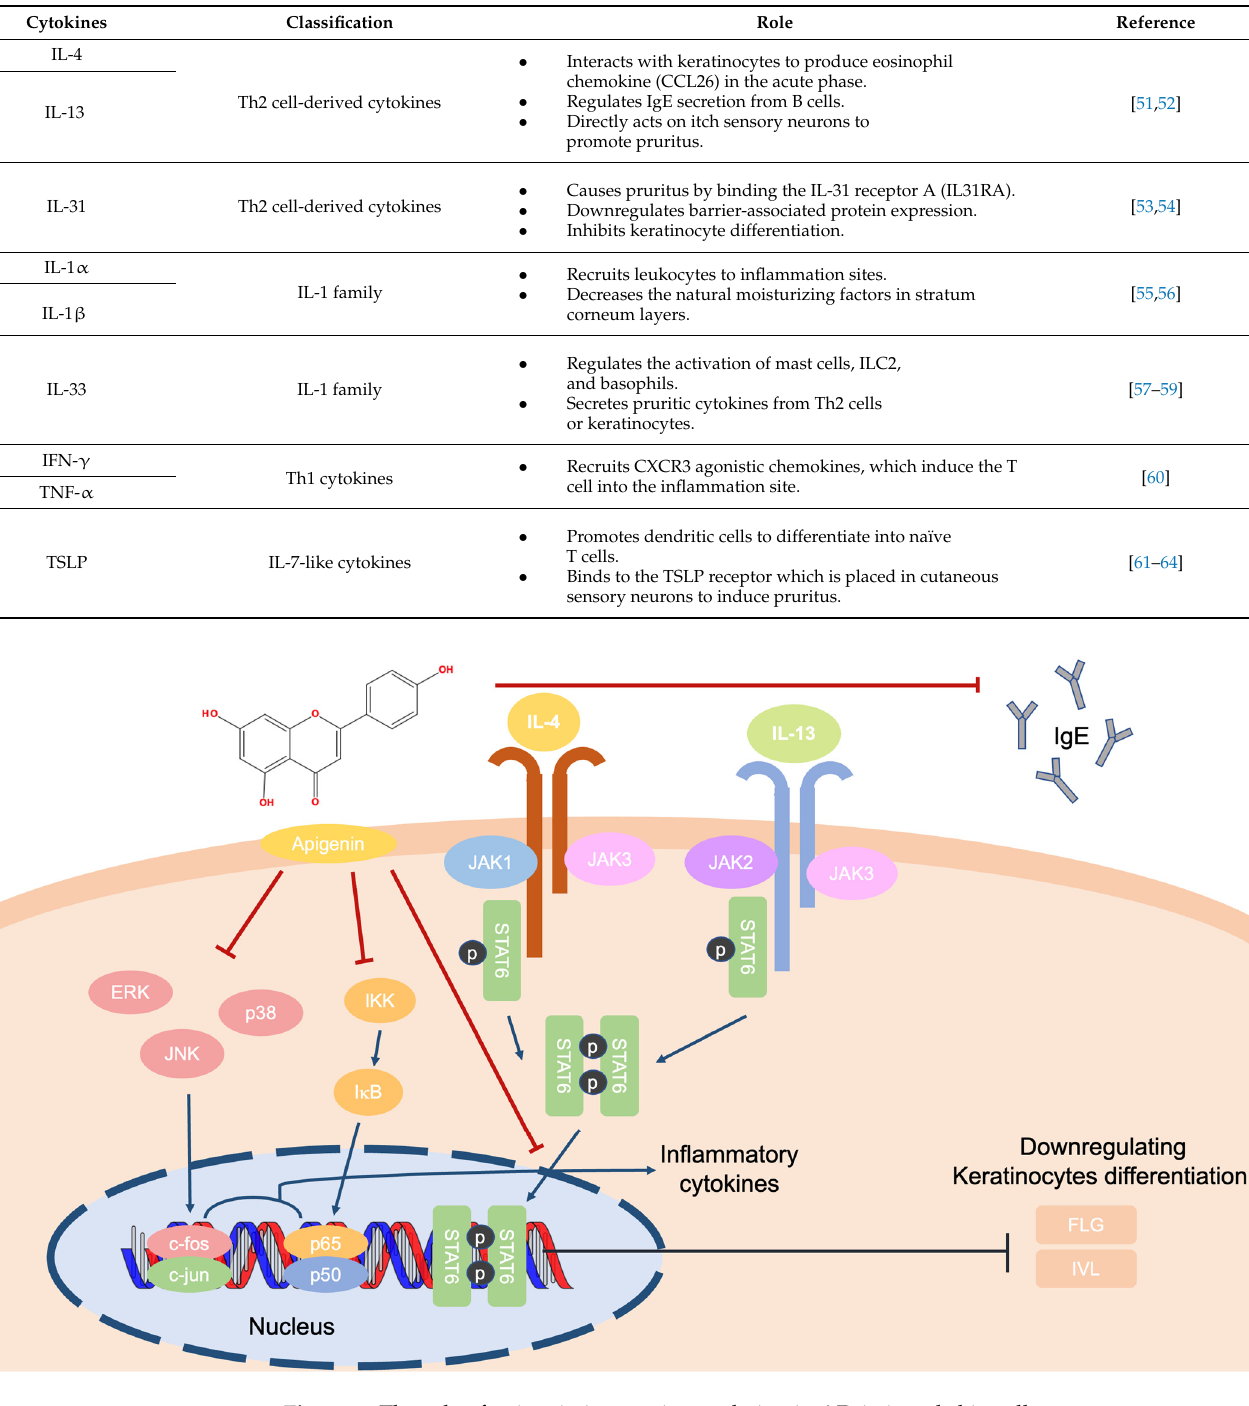
Figure 4. The role of apigenin in protein regulation in AD-irritated skin cells. Table 1. The cytokines and chemokines that stimulate AD.